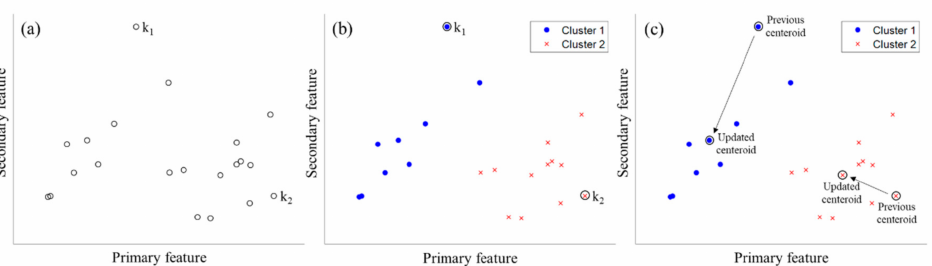
Figure 9. Example of K-medoids clustering application for 21 data points with two clusters. ( a ) Random selection of two medoids; ( b ) data categorization according to the two medoids; ( c ) updated location of the two